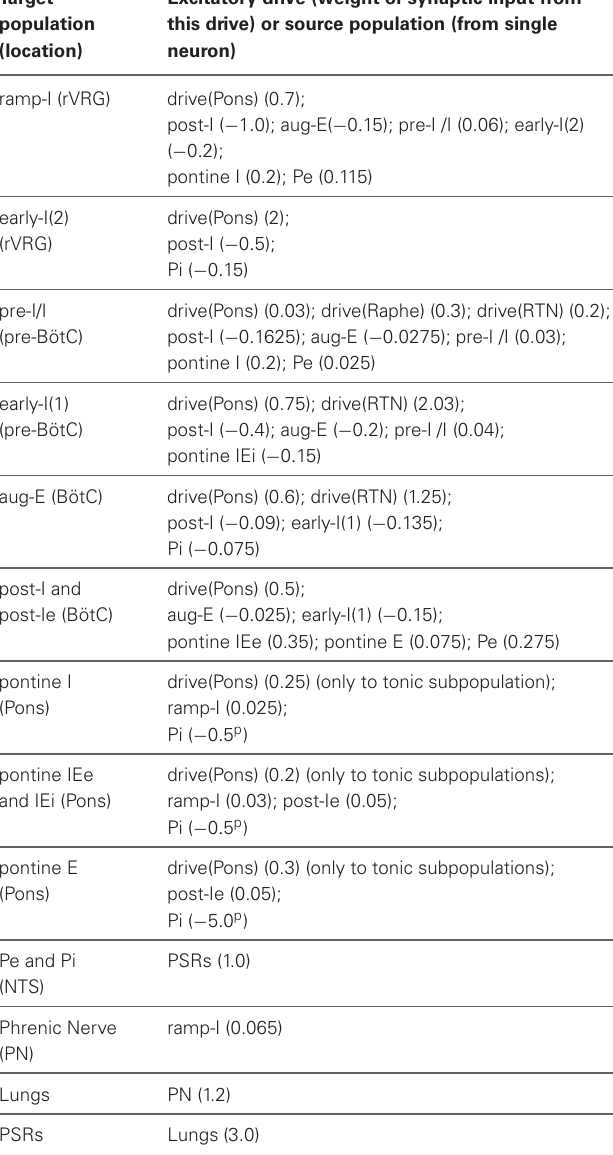
Table A3 | Weights of synaptic connections in the